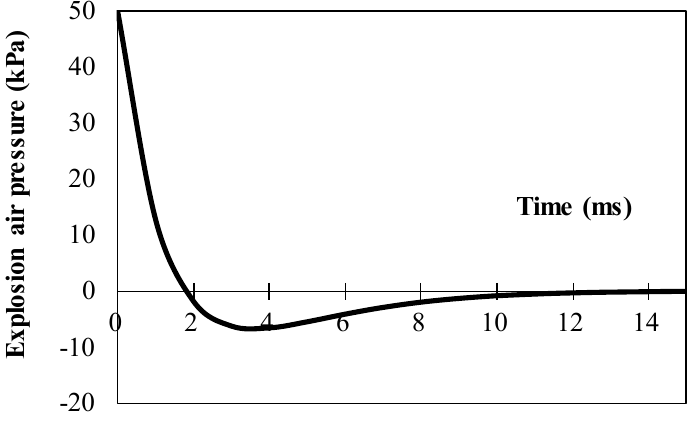
Figure 4. Friedlander explosion air pressure wave ( p m = 50 kPa and t d = 1.8 ms). The dynamic responses of the hybrid system caused by the explosion load were analyzed complying with the thicknesses of the steel plate and the φ 100 mm CFRP pipe varying from 9 to 10 mm and from 5 to 10 mm, respectively. According to [36], the damping coefficients for both the steel and CFRP are assumed as viscous damping C = 2 ζ